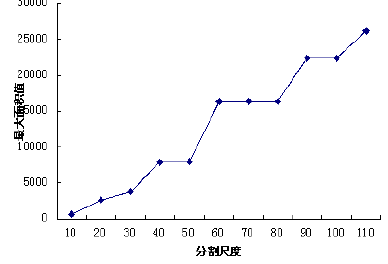
Figure 2. Relationship between segmentation scales and maximum area values